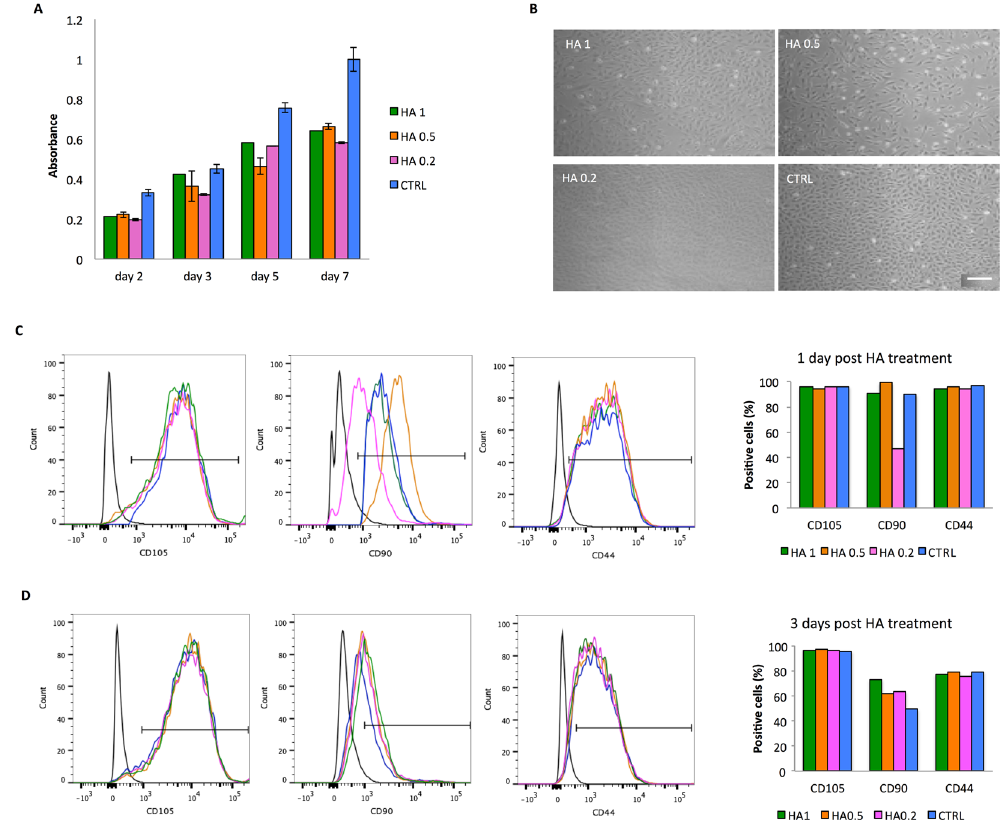
Figure 2. Effect of HA dilutions (0.2–1 mg/ml) on MSC viability, morphology, and surface markers. Temporal changes in the %AB are shown as representative of the presence of metabolically active cells over time revealed by Alamar blue assay (A) . A cumulative increase in %AB reduction reflects ongoing cell proliferation when exposed to serial HA dilutions (range). MSC grown in absence of HA are also reported for comparison (CTRL). Data are shown as mean of three independent biological replicates ± SD. Images representing cell morphology at day 1. 10X magnification. Scale bar: 20 μ m ( B ). Histograms from flow cytometry analysis showing the percentage of cells positive for MSC-associated markers (CD105, CD90, and CD44) at 1 ( C ) and 3 ( D ) days post HA-treatment. MSC grown in absence of HA are reported for comparison (CTRL). Graphs showing the quantification of cells positive for the tested markers are reported on the right